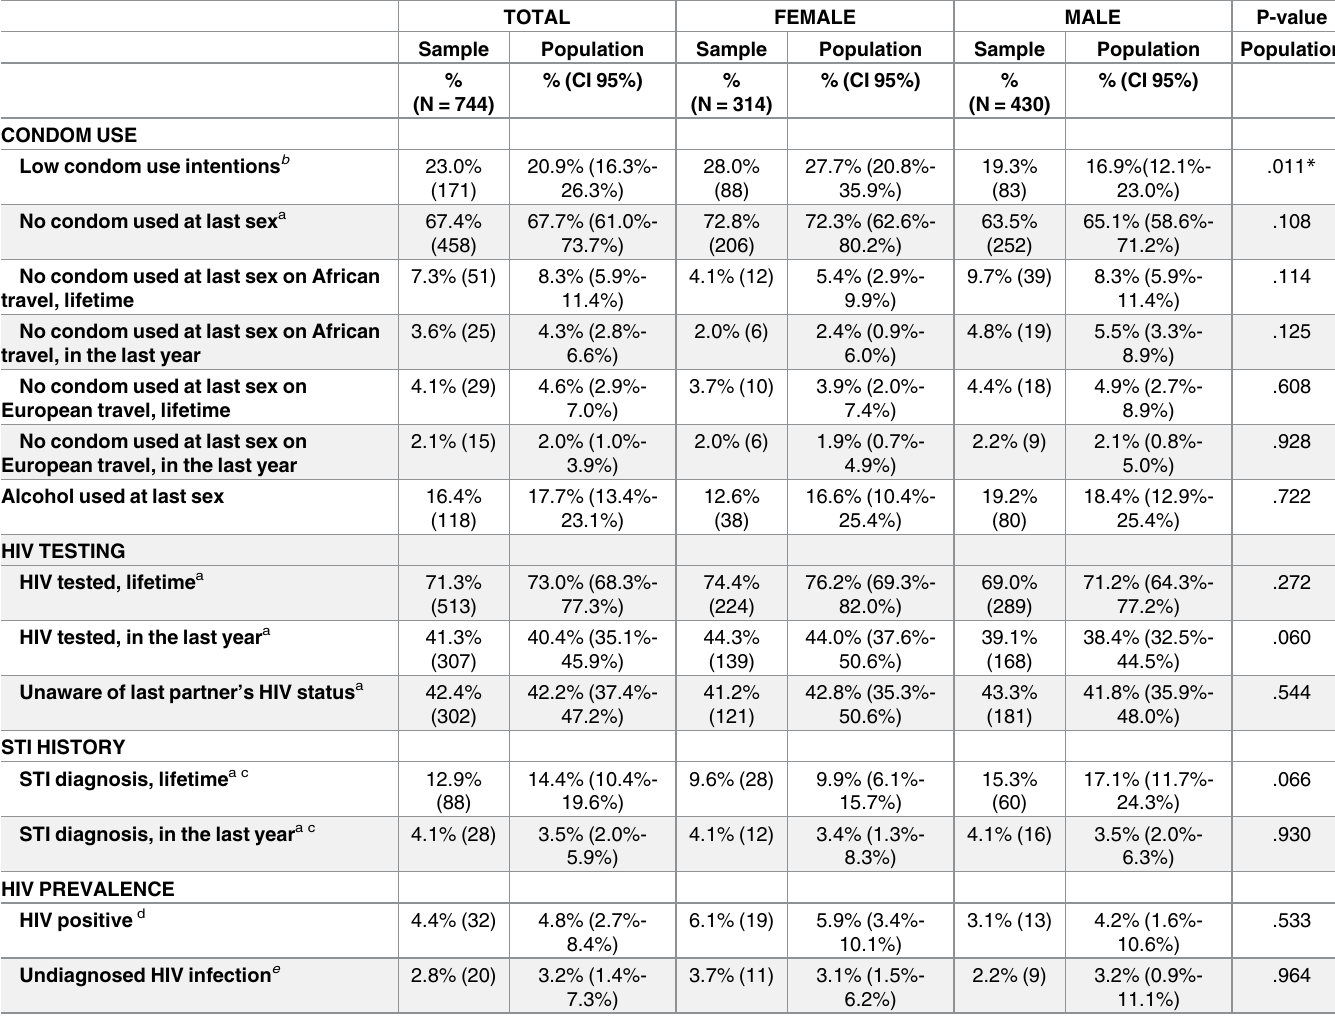
Table 4. Sexual health behavior of the sample (unweighted) and population estimatesof sub-Saharan African migrants socializing in Antwerp city (weighted), stratified by